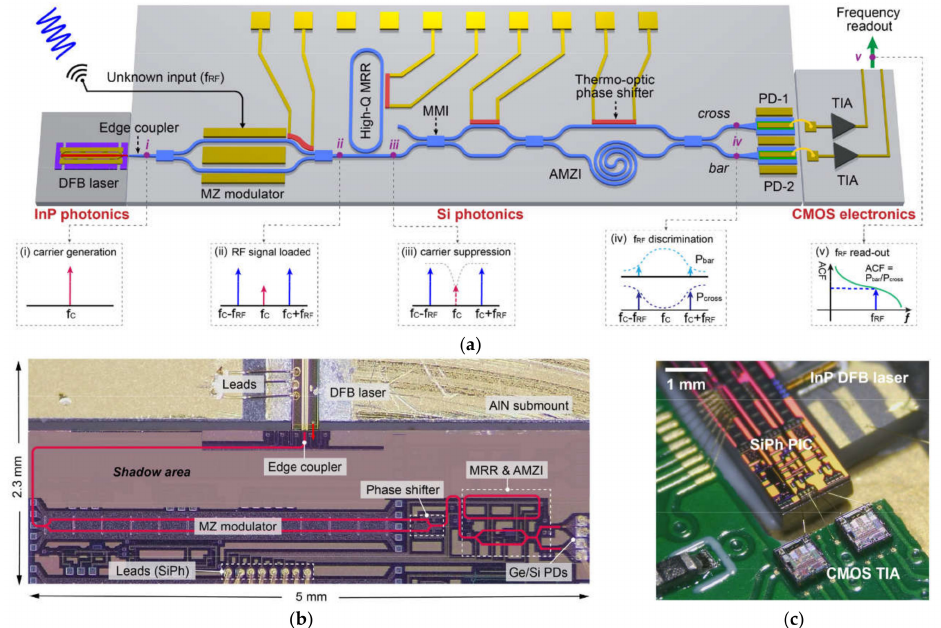
Figure 21. Photonic–electronic fully chip-integrated IFM system: ( a ) Illustration and principles of operation of the system; ( b ) top-view micrograph of the hybrid-integrated InP DFB laser and SiPh PIC; ( c ) photograph of the implemented fully on-chip MWP IFM system. DFB laser—Distributed feedback laser; MZ modulator—Mach–Zehnder modulator; High-Q MRR—High quality factor microring resonator; MMI—Multi-mode interference splitter; AMZI—Asymmetrical MZ interferometer; PD— Photodiode